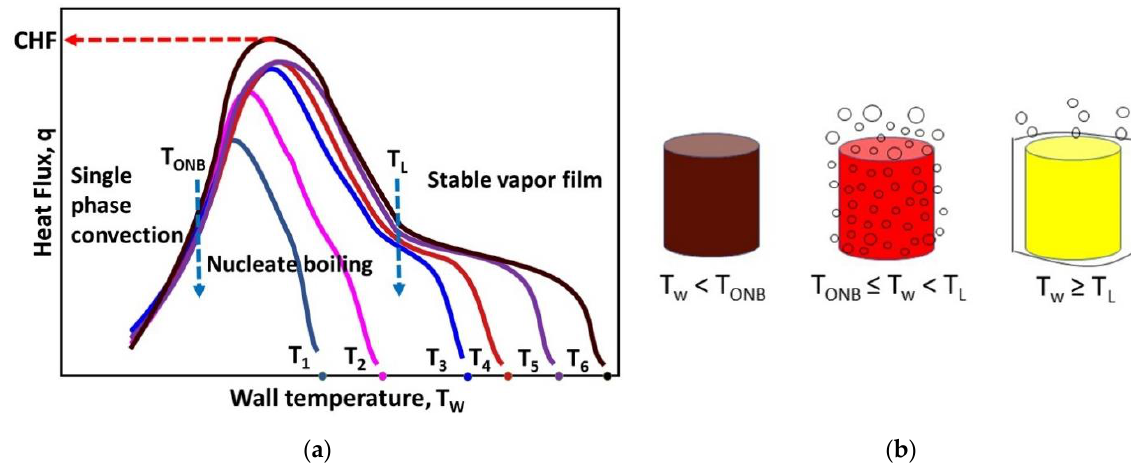
Figure 2. Schematic representation of ( a ) boiling curves corresponding to the continuous cooling of probes from several initial temperatures, T 1 , T 2 , …, T 6 and ( b ) heat transfer regimes during quenching by immersion.